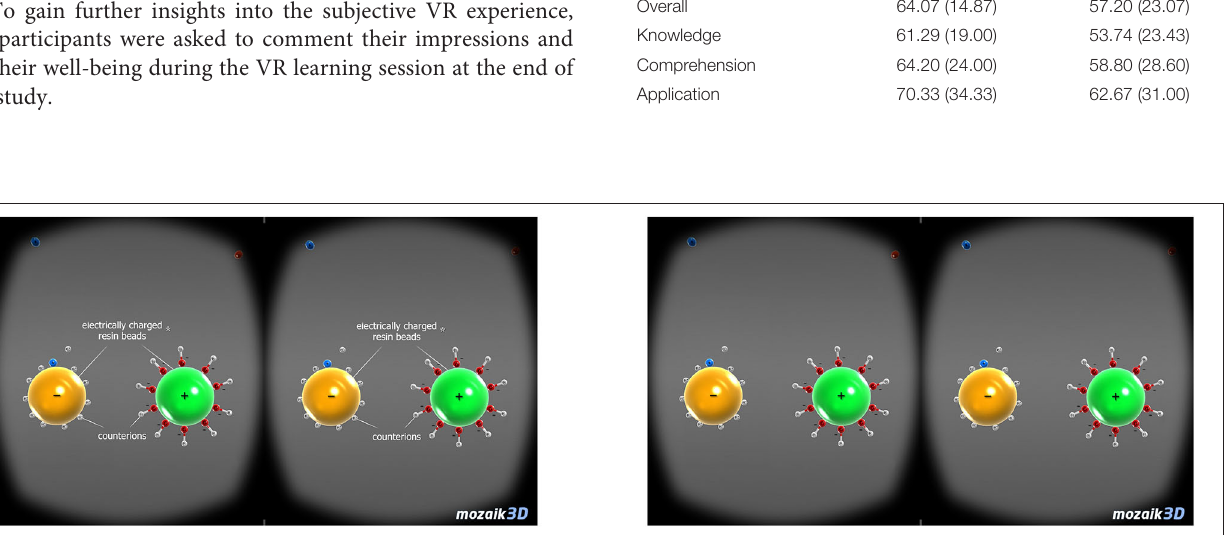
FIGURE 1 | Virtual reality learning material with (left) and without (right) annotations.